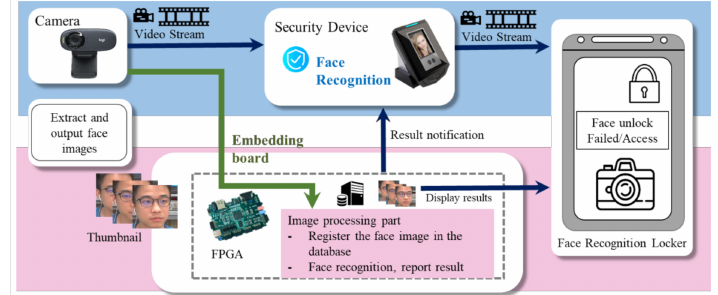
Figure 1. The architecture of a typical face recognition embedded system on a security